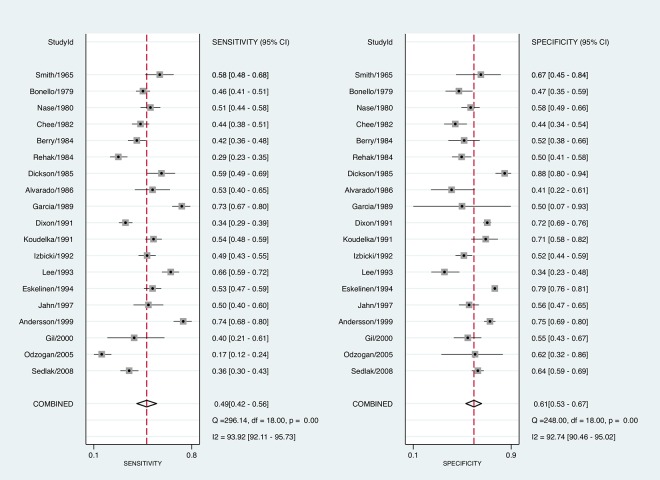
Paired Forest Plots of the Sensitivity and Specificity of DRE for the diagnosis of appendicitis.